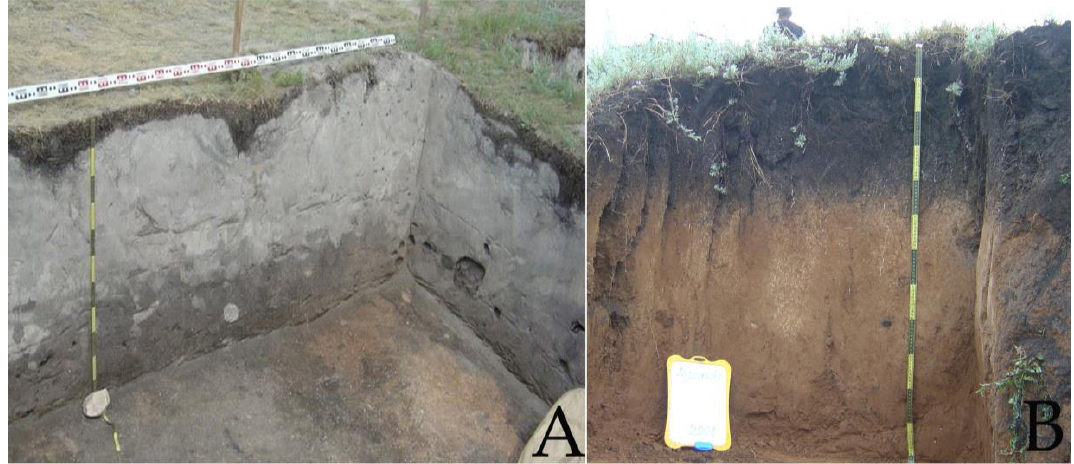
Figure 2. Soil profiles: A —archaeological pit; B —background soil.